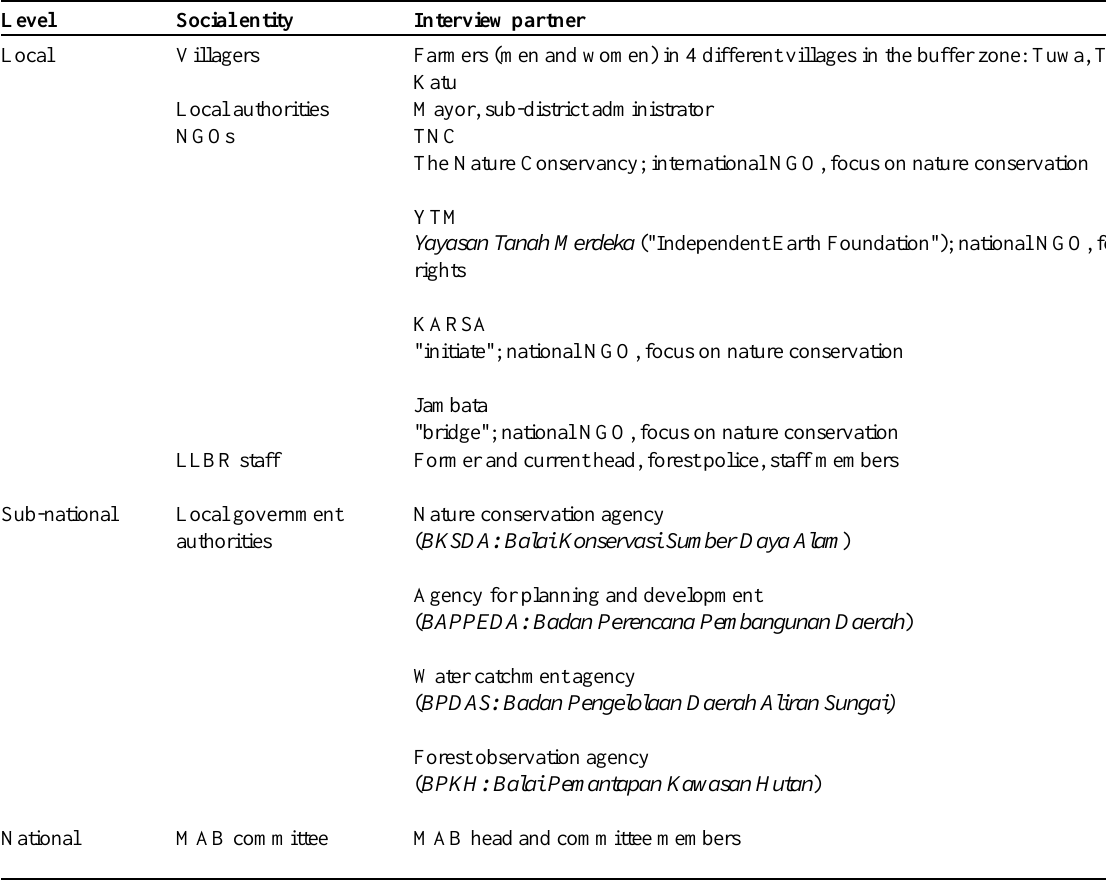
Table 2 . Overview of interviews and group discussions in Lore Lindu Biosphere Reserve